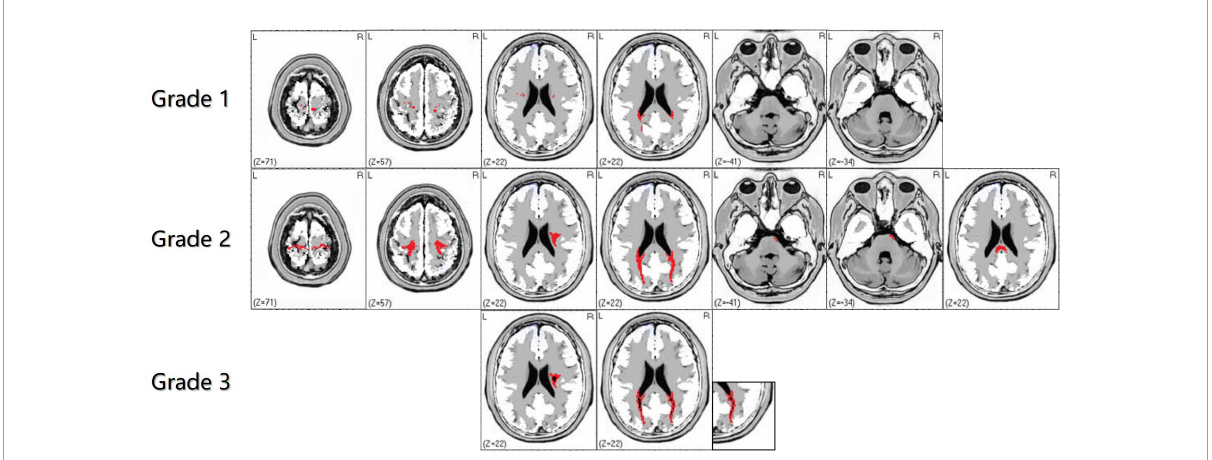
FIGURE3 The characteristics of white matter lesions should be graded by imaging, including grade 1: sporadic punctate white matter lesions; grade 2: patchy or continuous linear white matter lesions; grade 3: obvious cavity-like changes in the lesion site. In the supratentorial and infratentorial structures, the damage degree of the corticospinal tract and medial lemniscus should shall be highlighted in the transverse and coronal sections of brain magnetic resonance imaging (MRI). Grade 1 is defined as discontinuous white matter lesions, and grade 2 is defined as continuous white matter lesions. The red area refers to WMHs, and the black part of the red area refers to necrosis or cavity formation in